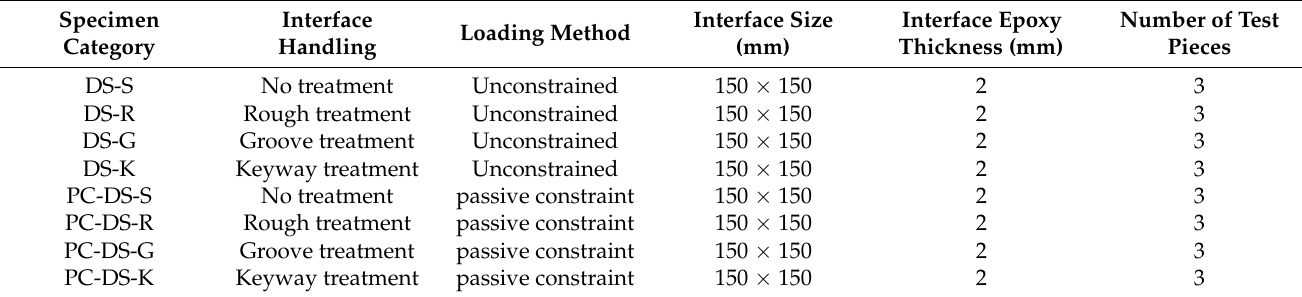
Figure 3. Material performance test of the UHPC. Table 2. Mix the proportion of UHPC.